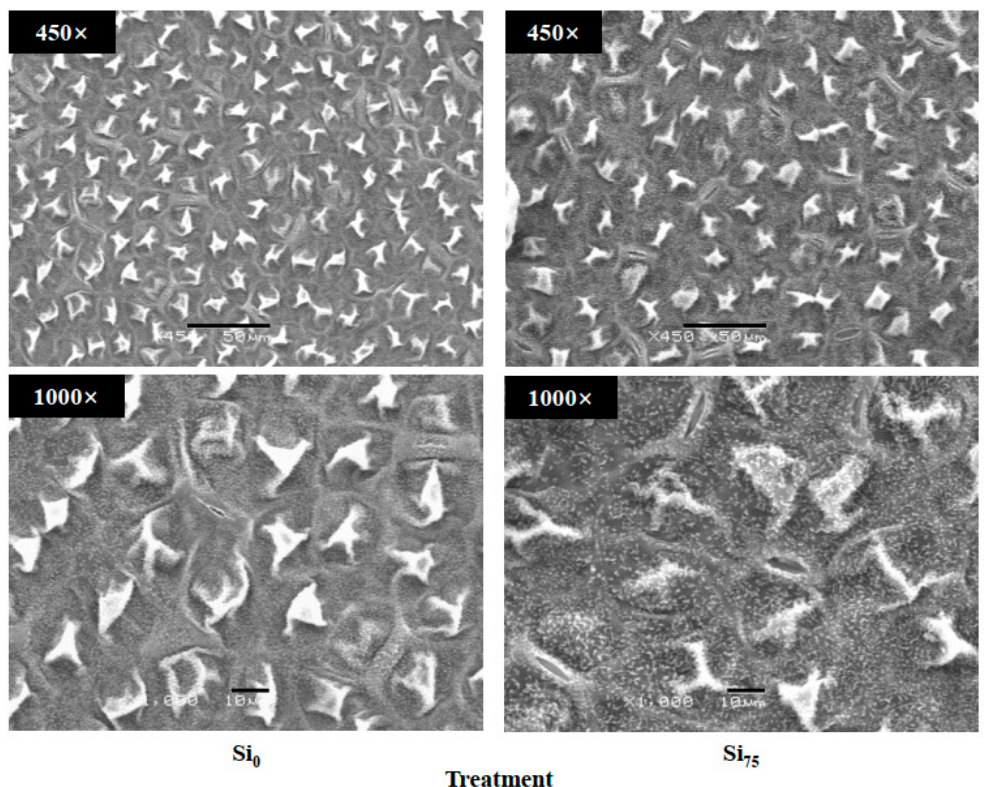
Figure 1. Leaf surface of cutting-propagated poinsettia subjected to a high temperature stress. Si 0 , 0 mg ∙ L − 1 Si; Si 75 , 75 mg ∙ L − 1 Si.